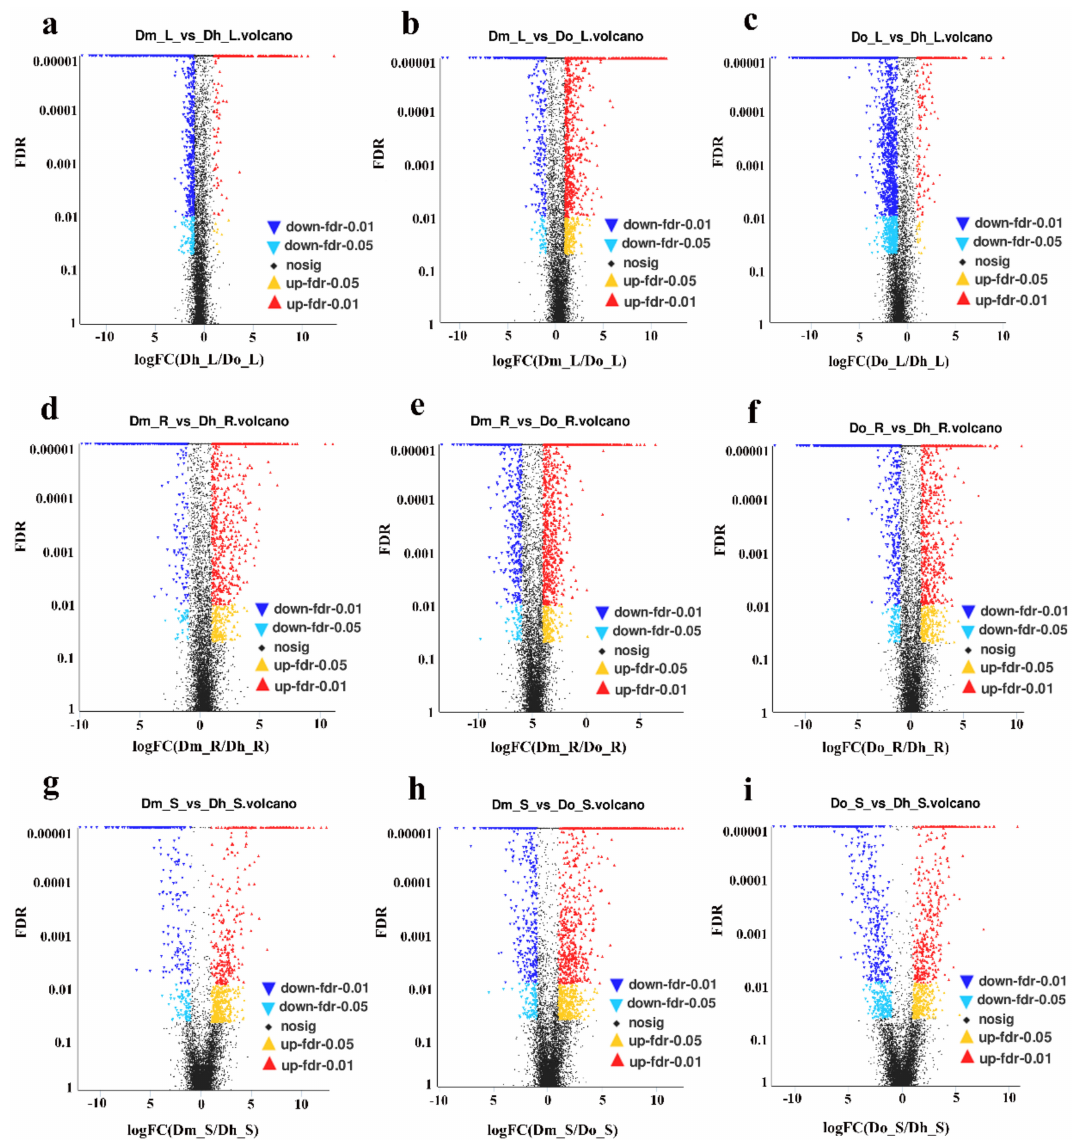
Figure 3. Volcano plots of the DEGs in di ff erent comparisons. Red dots indicate significant up-regulation of genes, and blue dots indicate significant down-regulation of genes. Black dots represent non-DEGs. ( a ) Dm_L vs. Dh_L volcano; ( b ) Dm_L vs. Do_L volcano; ( c ) Do_L vs. Dh_L volcano; ( d ) Dm_R vs. Dh_R volcano; ( e ) Dm_R vs. Do_R volcano; ( f ) Do_R vs. Dh_R volcano; ( g ) Dm_S vs. Dh_S volcano; ( h ) Dm_S vs. Do_S volcano; ( i ) Do_S vs. Dh_S